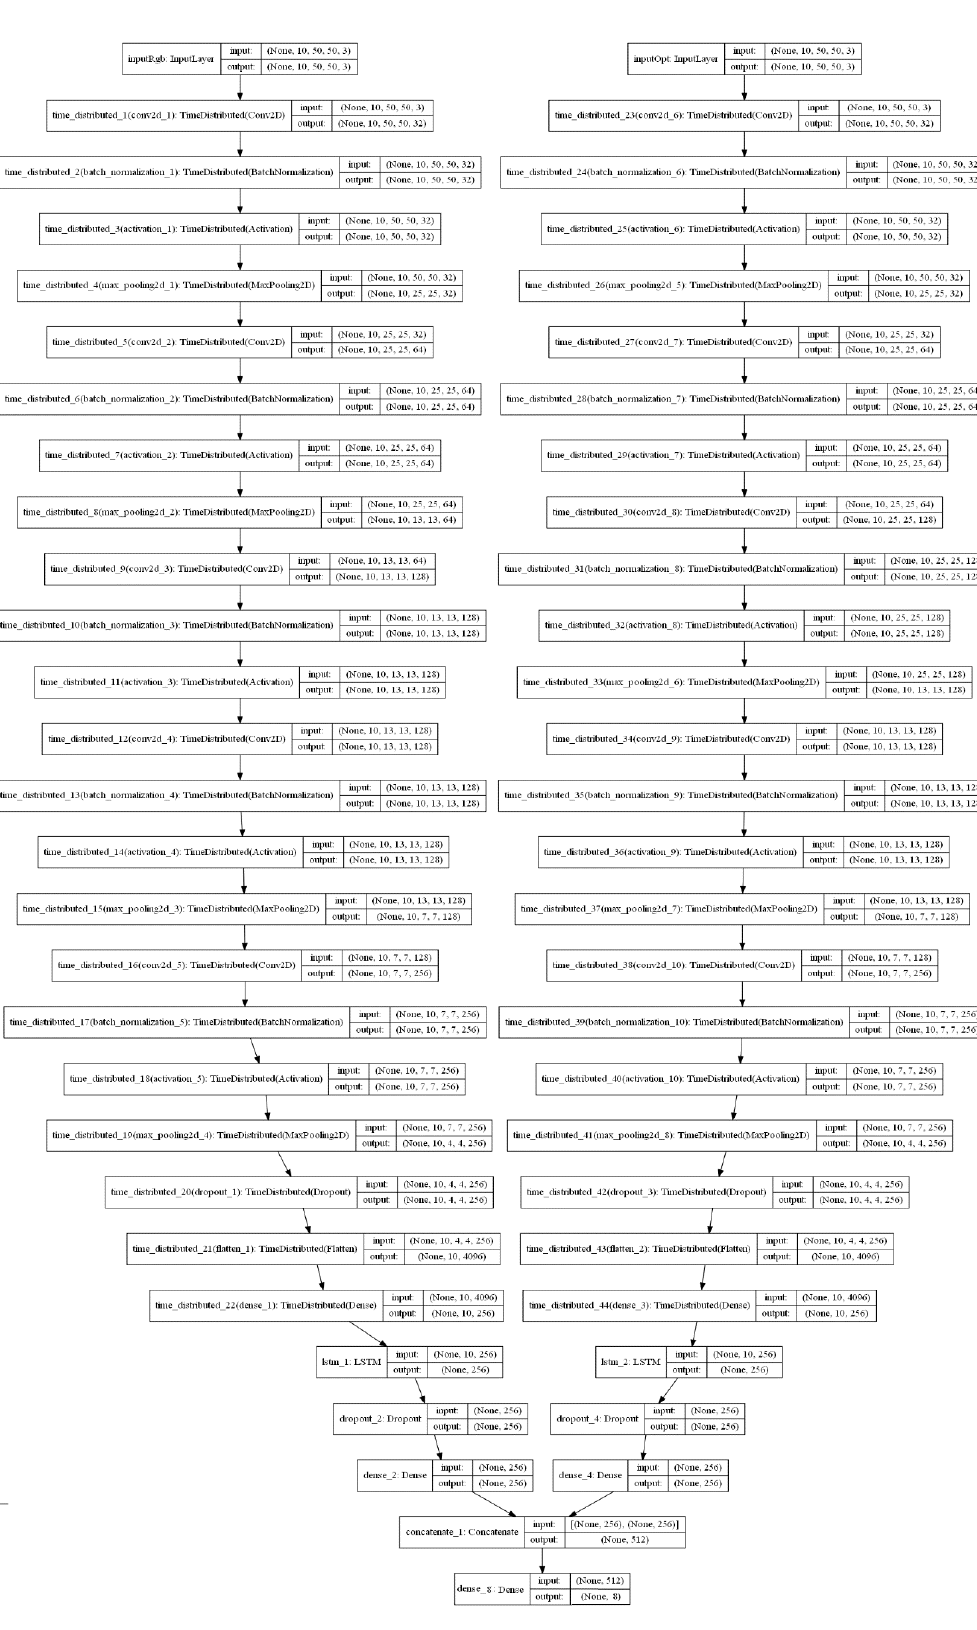
Figure A1. Visualizing the Proposed Dual-CNNSELSTM Architecture.